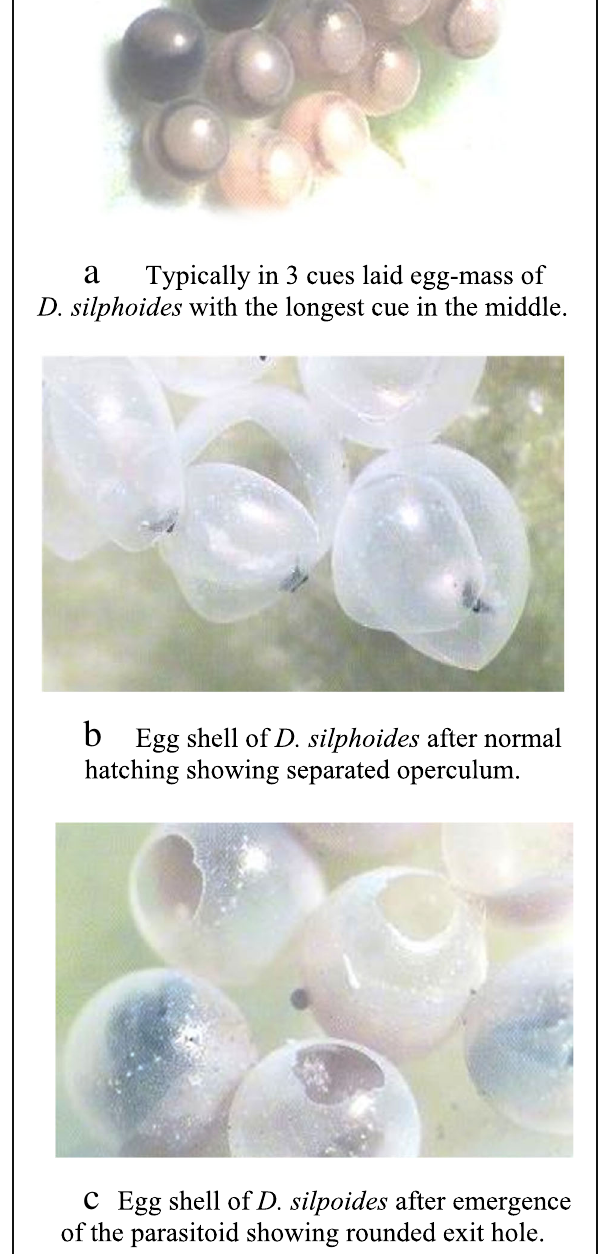
Fig. 1 a Typically in 3 cues laid egg mass of D. silphoides with the longest in the middle. b Egg shell of D. silphoides after normal hatching showing separated operculum. c Egg shell of D. silphoides after emergence of the parasitoid showing rounded exit hole